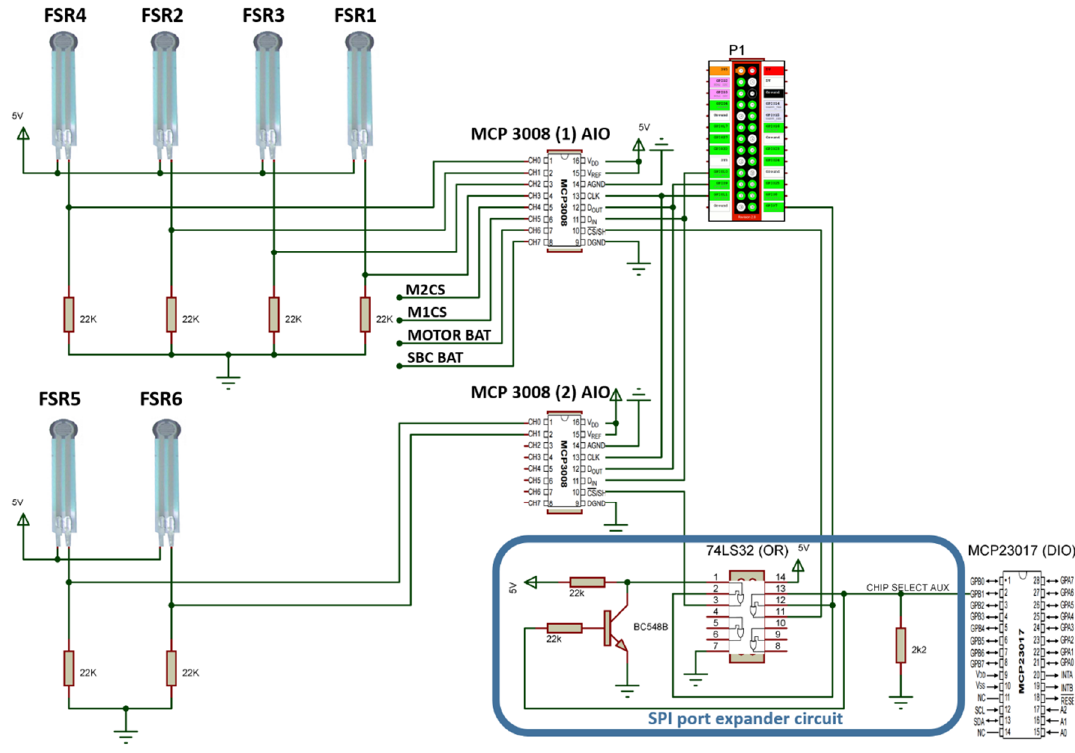
Figure 7. Hardware diagram associated with AdcDriver.